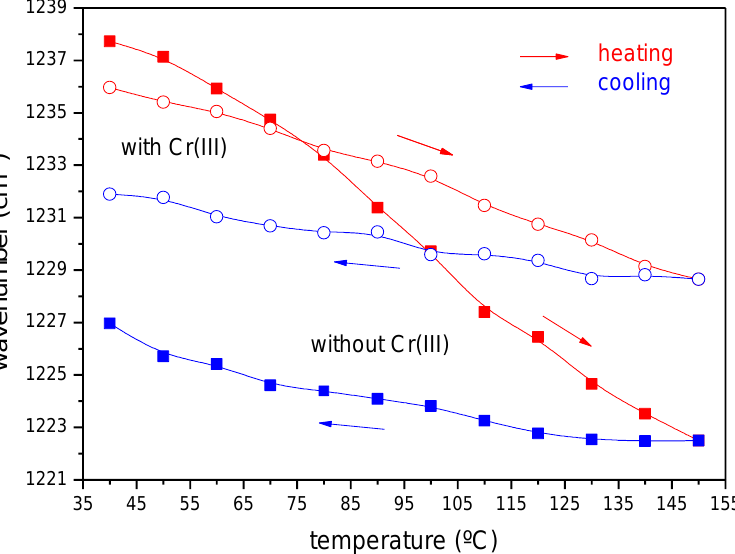
Figure 3. Shift of the amide III band as a function of the temperature (heating and cooling runs), showing the structural hysteresis. 2.2. Solubilisation of Chrome-Tanned and Chromium-Free Leather Shavings: Effect of Temperature Three thermal regimes were assessed to investigate the solubilisation of organic com- pounds from the leather shavings. The reactors were running for 55 days to guarantee the solubilisation step, and different parameters were analysed to study the performance un- der the selected experimental conditions. The following results have been calculated in all cases by subtracting the influence of the inoculum at different temperatures (35, 42 and 55 °C), as a blank. No valuable biogas production was recovered with the experimental set-up used, most likely due to the recalcitrant nature of these wastes, and that the inves- tigation has focused on the solubilisation of organic matter from the leather shavings to the liquid phase. 2.2.1. Study of pH Evolution The pH is an indicator of the stability and evolution of AD, since the different micro- biological groups involved work at optimal and inhibitor pH values. The evolution of pH in the reactors at the different temperatures is shown in Supplementary Materials, Figure S2. It can be highlighted that the pH is acidic, corresponding to hydrolysis and acidogen- esis phases (5.5 – 7.0). The elapsed time until reaching the pH stability varied according to the substrate composition and temperature operation. The shortest run lasted 25 days un- der thermophilic (55NC) conditions. The mesophilic (35NC) and intermediate tempera- tures (42NC) of the samples without chromium required more time until pH stability (around 35 days). Similar times were observed for all the chrome-containing samples (55C, 42C and 35C). It is worth mentioning that the stabilized pH for 55NC was higher than that of 55C (8.5 versus 7.5), which could be related to a higher stability [43], since pH under 8.5 prevents the methanogenesis inhibition [44]. 2.2.2. Volatile Solids (VS) Evolution The VS production over time followed different patterns depending on the substrates and temperatures. VS concentration remained constant until day 25 in the mesophilic